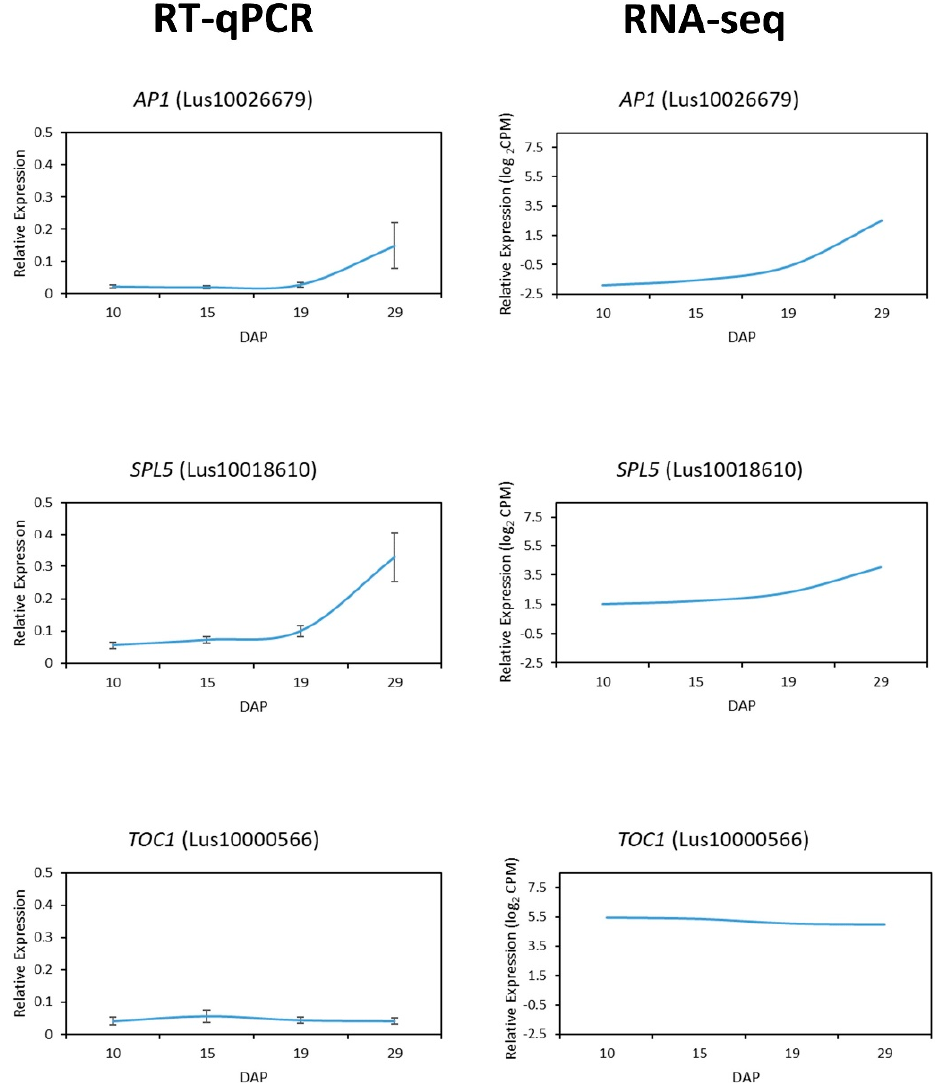
Figure 5. Expression of AP1 , SPL5 , and TOC1 using normalized RNA − seq and RT − qPCR data. Validation of RNA − seq expression was conducted by comparing patterns of expression derived from RT − qPCR to those obtained from our RNA − seq analysis for three important flowering − time genes: AP1 , SPL5 , and TOC1 . Data plotted for RT − qPCR are expressed as 2 −Δ Ct and data plotted for RNA − seq are expressed as log 2 CPM. Normalization for RT − qPCR was performed using the reference gene glyceraldehyde 3 − phosphate dehydrogenase ( GAPDH ).